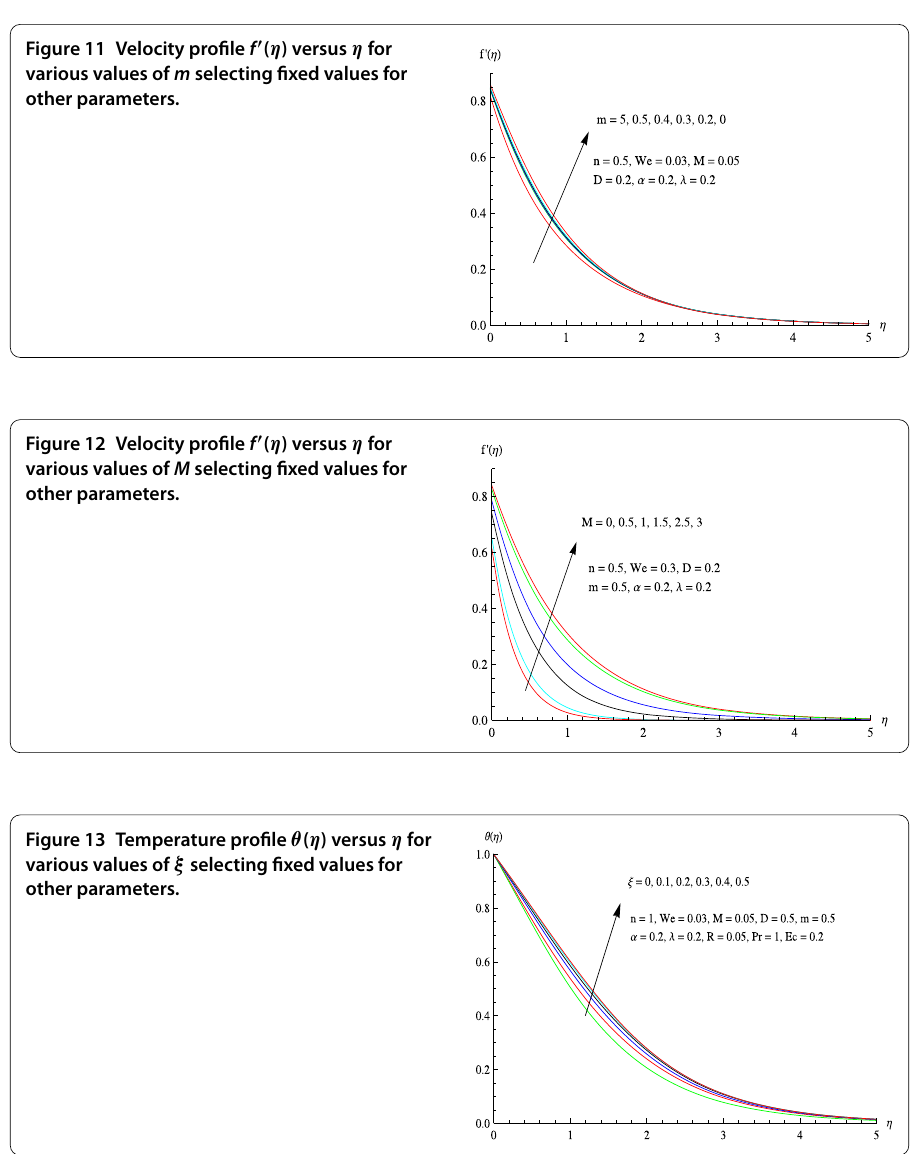
Figure 11 Velocity profile f (cid:2) ( η ) versus η for various values of m selecting fixed values for other parameters.